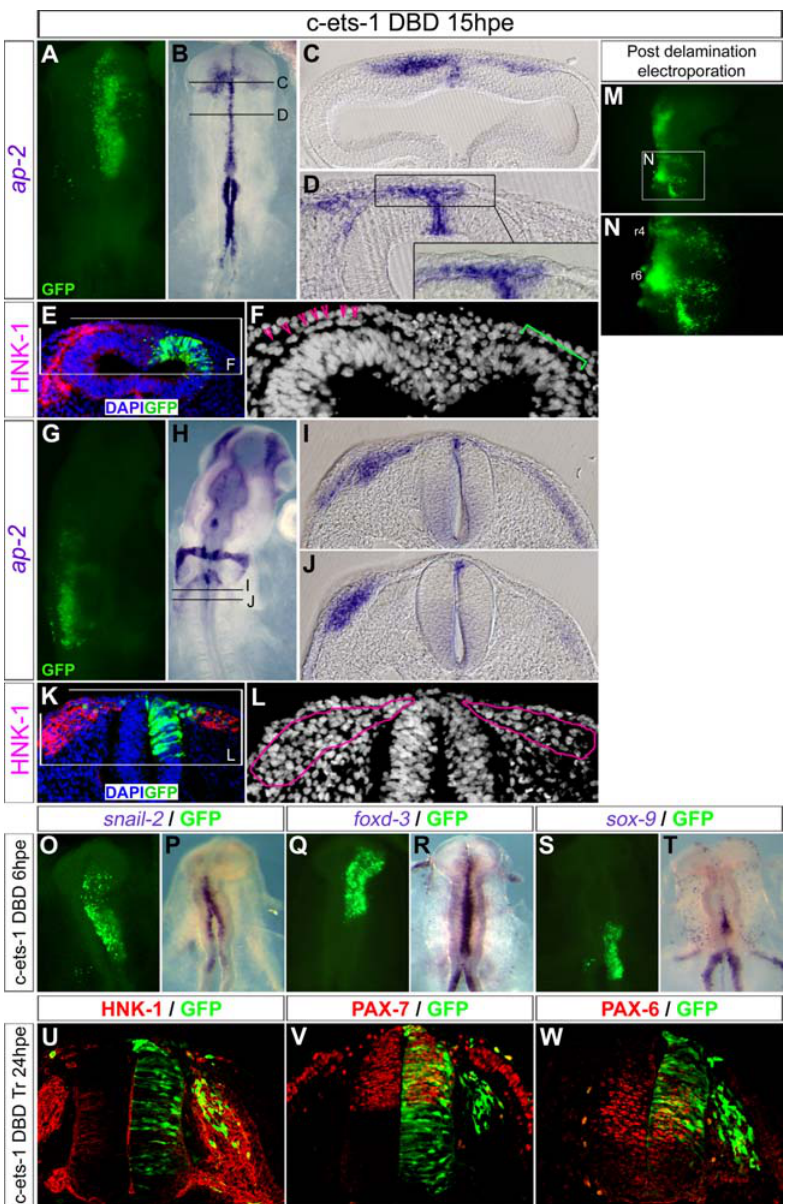
Figure 3. Ets-1 Activity Is Required for Cranial but not Trunk Delamination. (A–L) Analysis of cranial NCCs delamination in HH7-9 chick embryos electroporated by c-ets-1 DBD and harvested at 15 hours post electroporation (hpe). (A–D; G–J) Whole mount in situ hybridization using ap-2 probe. GFP expression in (A) and (G) indicates the electroporation zone. (C–D) and (I–J) are vibratome sections (30 m m) of embryos presented in (B) and (H) respectively. (E–F; K–L) Transversal cryosections (14 m m) labeled by immunofluorescence using anti-HNK-1 antibody and nuclear-stained by DAPI incorporation. Electroporated cells are detected by GFP expression. Pink broken lines in (L) outline the NCCs. (M–N) Analysis of NCC migration in embryos electroporated in the rhombencephalon at stage HH10 + when the delamination is in progress and harvested at 15hpe (stage HH14). (O–T) Analysis of NCC specification in chick embryos electroporated by c-ets-1 DBD at stage HH7-9 and harvested at 6hpe. GFP expression in (O), (Q) and (S) indicates the electroporation zone of the embryos presented in whole mount in situ hybridization using snail-2 , foxd-3 and sox-9 probes in (P), (R) and (T) respectively. (U–W) Analysis of trunk NCCs delamination in chick embryos electroporated by c-ets-1 DBD harvested at 24hpe. Transversal cryosections (10 m m) were labeled by immunofluorescence using anti-HNK-1 (U), anti-Pax-7 (V) and anti-Pax-6 (W) antibodies. Expression of c-ets-1 DBD in the head leads to a decrease or a lack of ap-2 (B–D, H–J) and HNK-1 expression (E, K). At cellular level, there is either a reduction of the size of the NCC stream on the electroporated side (L) or even a lack of NCCs between the ectoderm and the neural tube (E; F, green staple) while on control side NCCs are normally localized (B–D, ap-2 staining; F, pink arrow heads; L, left pink lasso). Data shown in A–D, E–F, G–J, K–L come from four distinct embryos respectively. This effect is restricted to the delamination step since inhibition of ETS-1 activity after the delamination does not affect the migration (M–N). Finally, c-ets-1 DBD does not prevent NCC specification as snail-2 (O–P), foxd-3 (Q–R) and sox-9 (S–T) remain expressed in the neural folds on both electroporated and control sides. At trunk level, misexpression of c-ets-1 DBD has no effect on dorso-ventral patterning, or on NCCs delamination and migration (U–W). r, rhombomere.